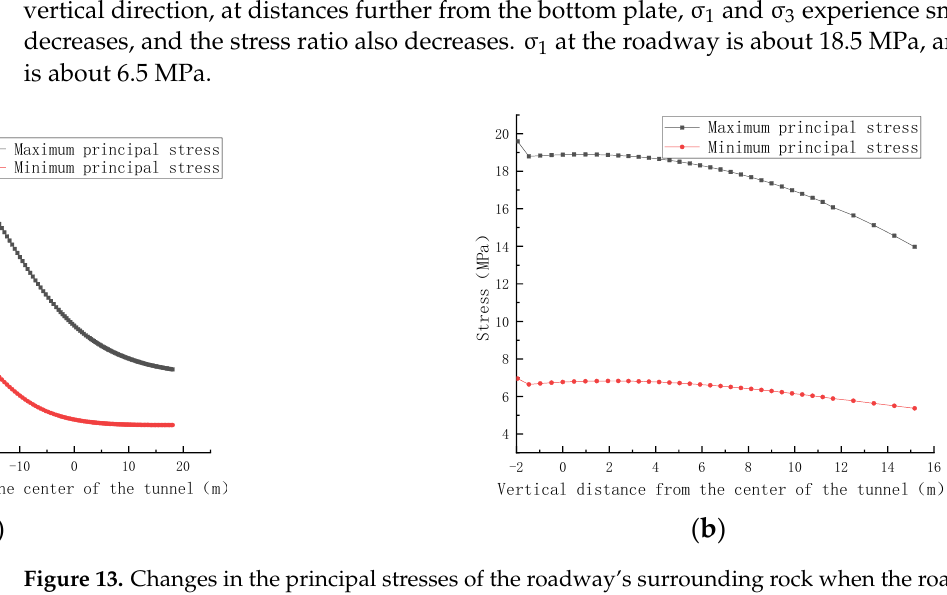
Figure 12. Principal stress distribution contour of the roadway’s surrounding rock when the roadway excavation along the floor. ( a ) σ 1 cloud. ( b ) σ 3 cloud.